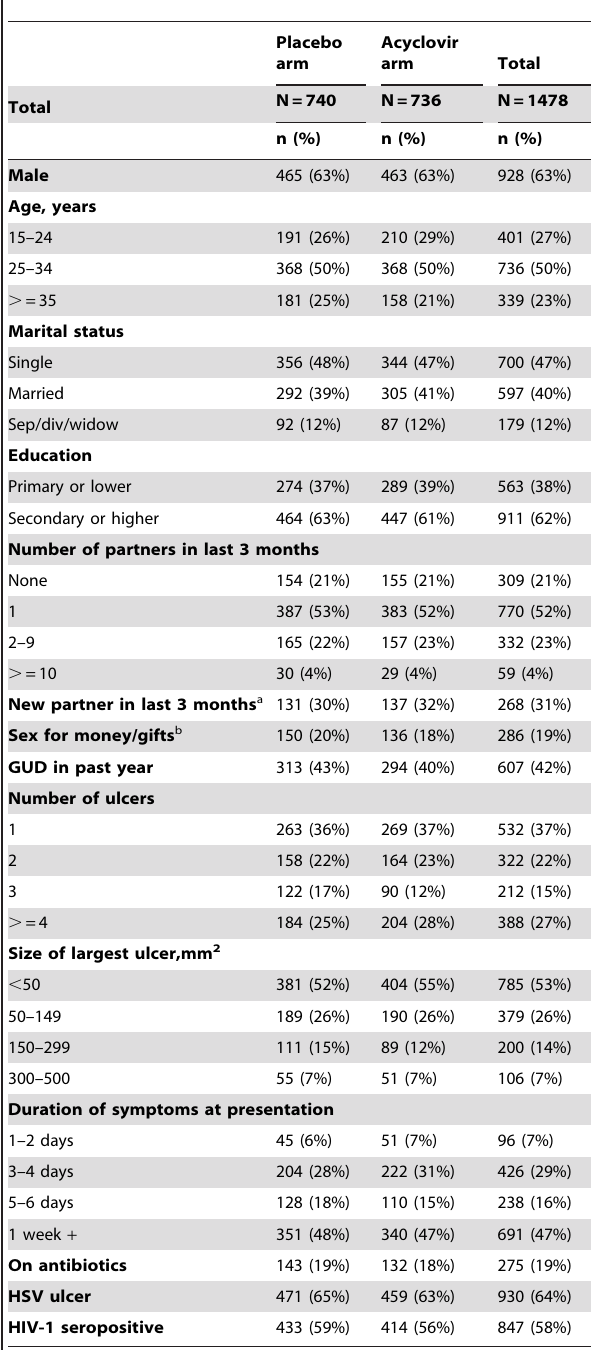
Table 1. Demographic, behavioural and clinic characteristics of 1478 trial participants with genital ulcer disease (GUD) at enrolment, by trial